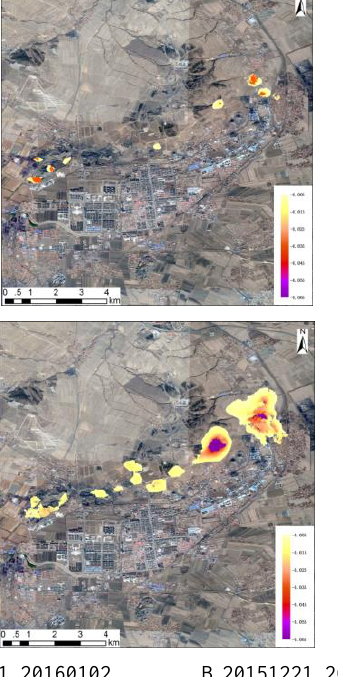
Fig.4 Mining subsidence results using DInSAR technique with Sentinel-1